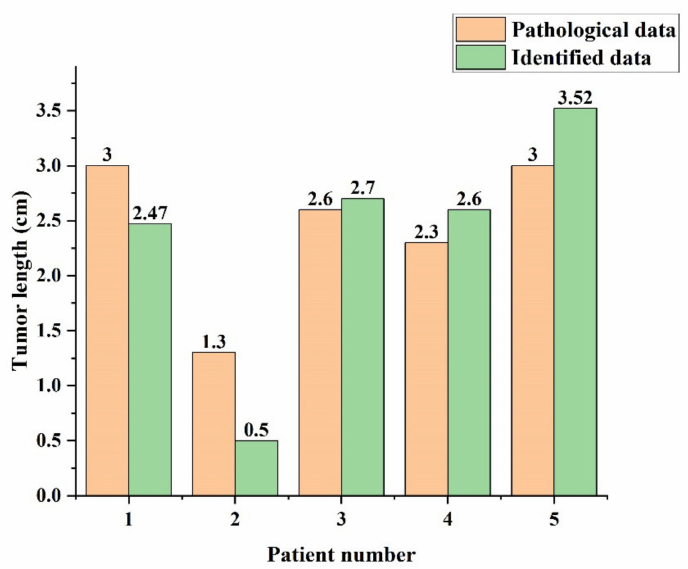
Figure 12. Comparison of tumor length by